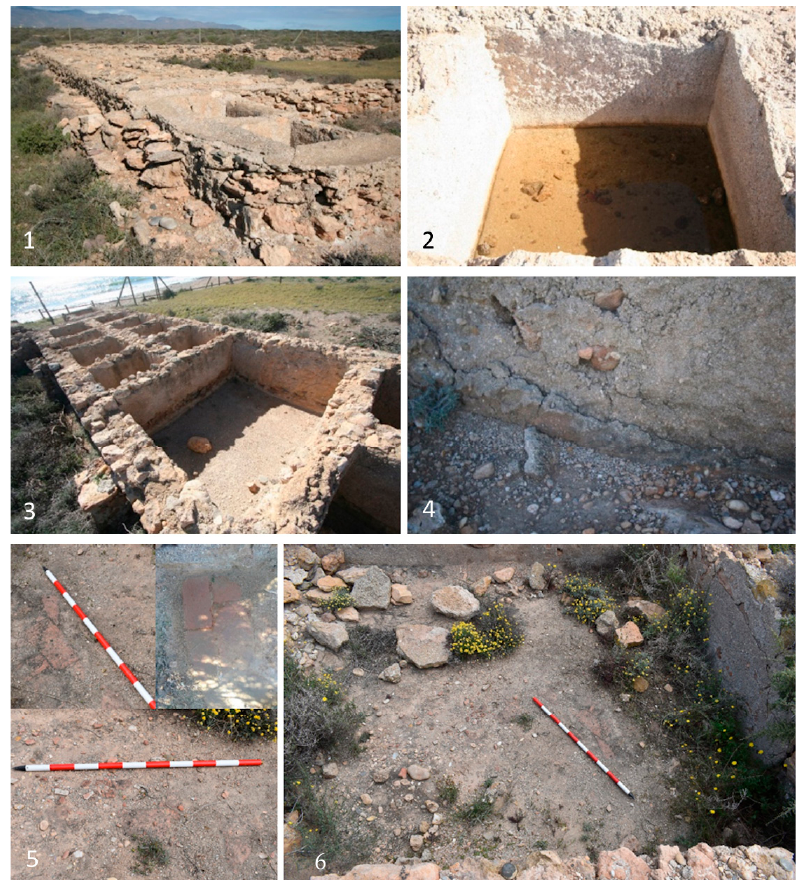
Figure 4. Details of building elements and environments. 1: construction detail of the SW corner of the officina ; 2: detail of the interior of one of the lacus ; 3: view of one of the sets of lacus ; 4: detail of the hydraulic plaster; 5 and 6: brick floor and detail of the pavement in the room identified as an administration or storage area.